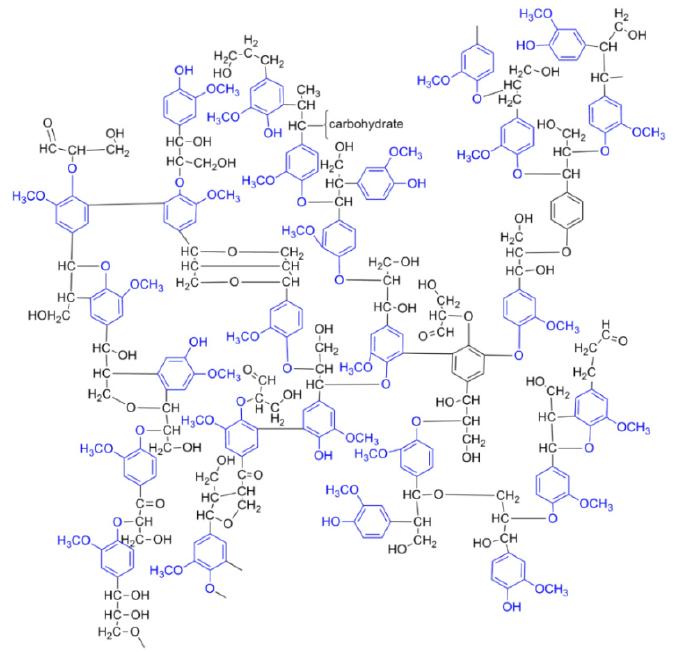
Figure 2. Structure in softwood